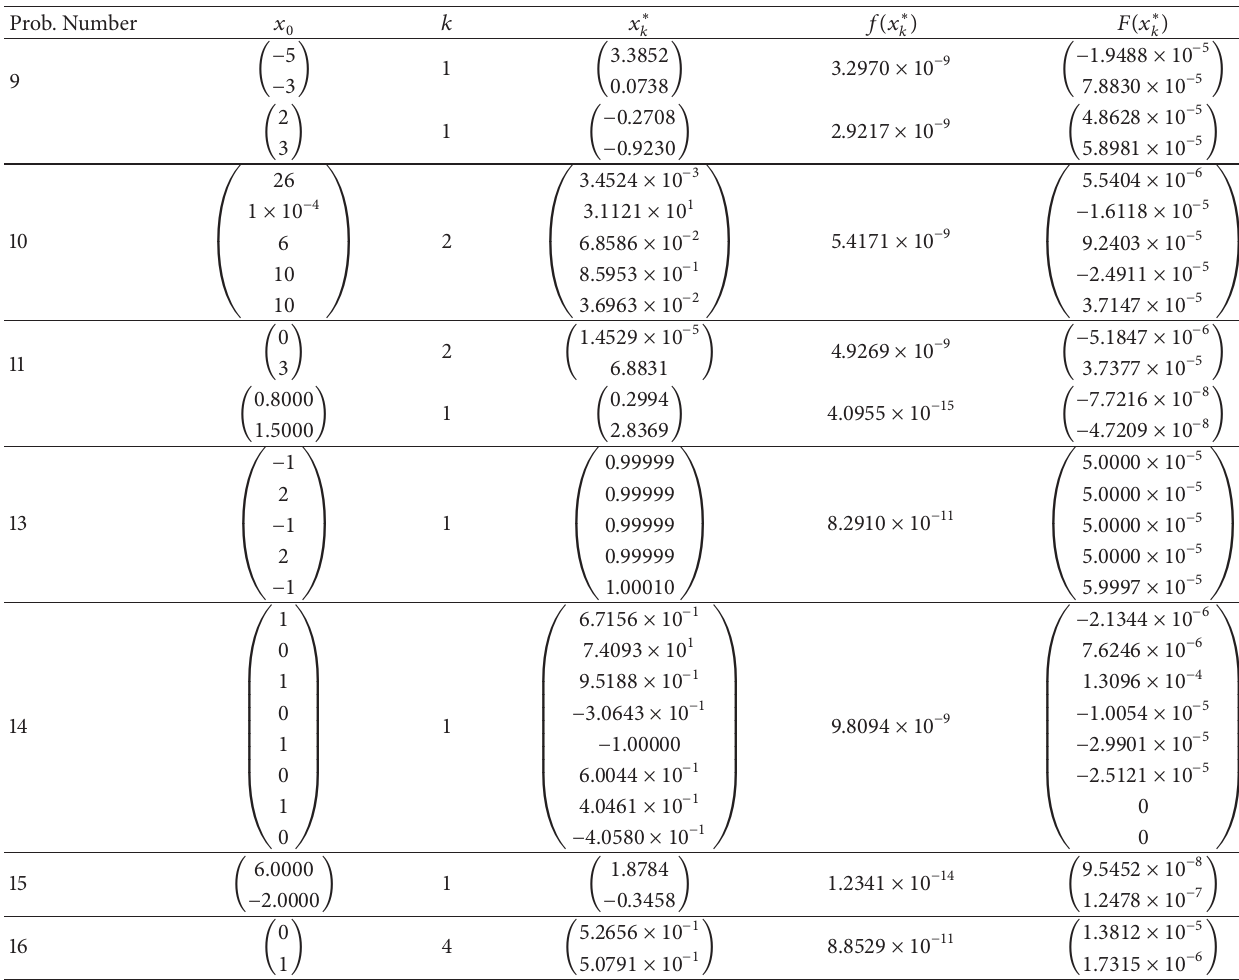
Table 3: Computational results for Problems